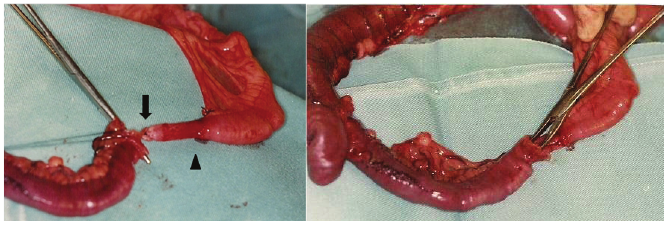
FIGuRE 2 - Preparation of terminal ileum. A. Resection of sero-muscular layer. B. Submucosa-mucosa 4cm long graft. Distal end (arrow). Proximal end (arrow head).